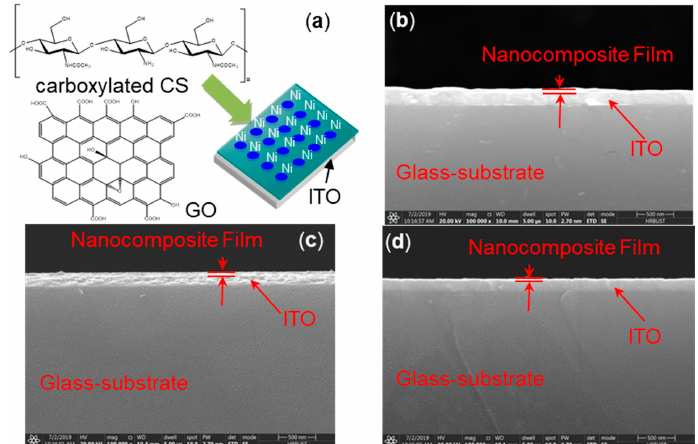
Figure 1. ( a ) Chemical structure of carboxylated chitosan (CS) and graphene oxide (GO) and sandwiched structure of ITO/CS:GO/Ni (right); ( b – d ) the cross-sectional profiles of CS:GO nanocomposite films coated on the ITO/glass substrates with a mass ratio of the chemical component CS:GO 2:1, 5:1, and 10:1, respectively.